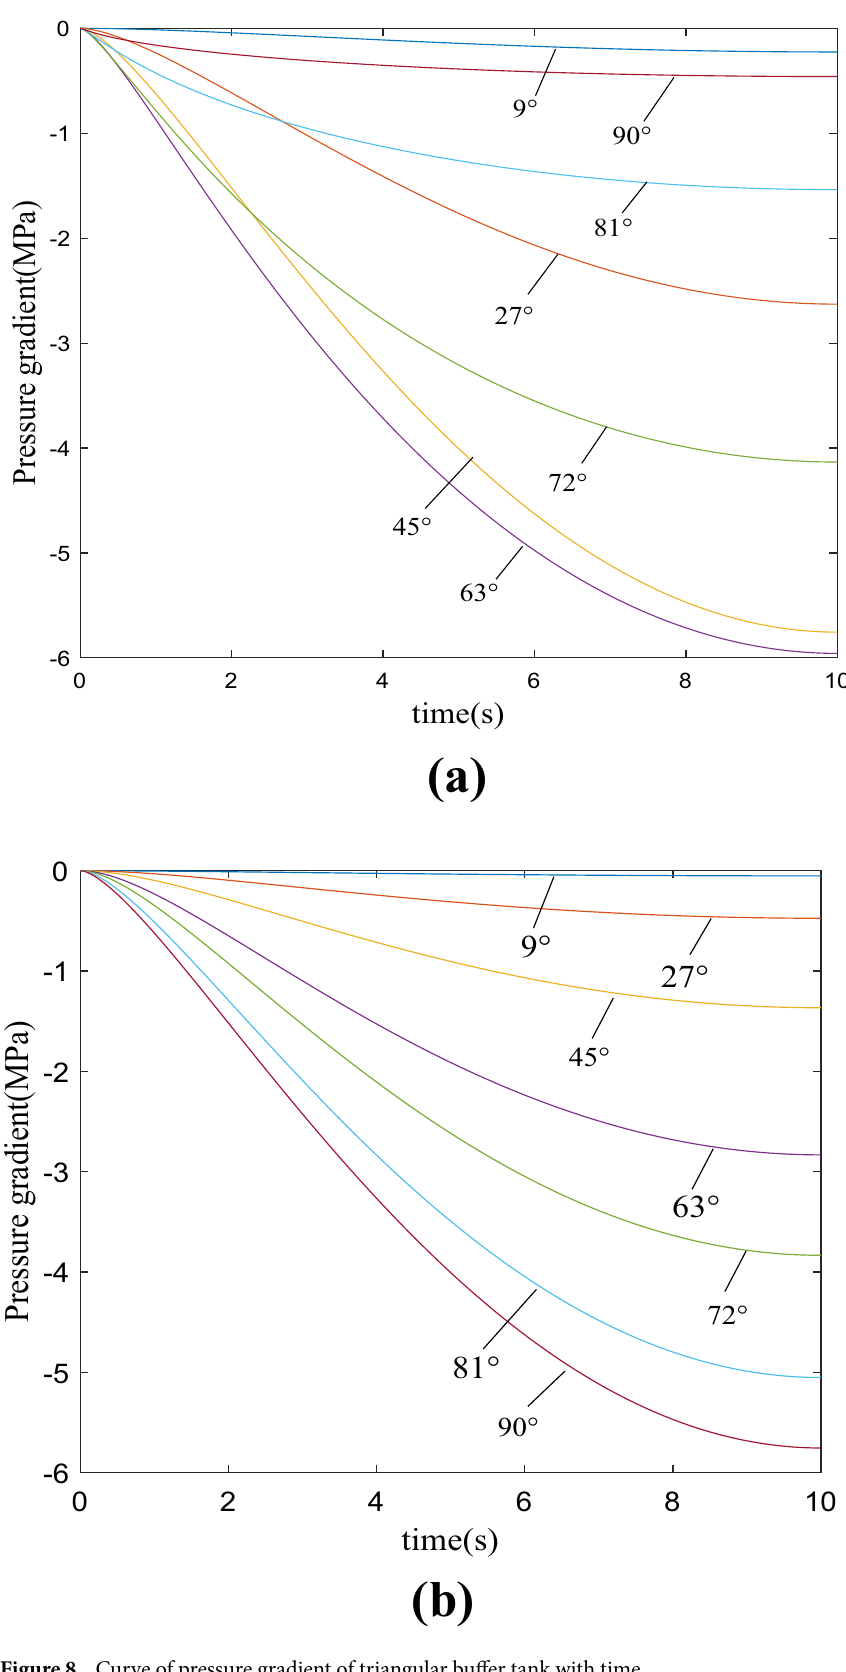
Figure 8. Curve of pressure gradient of triangular buffer tank with